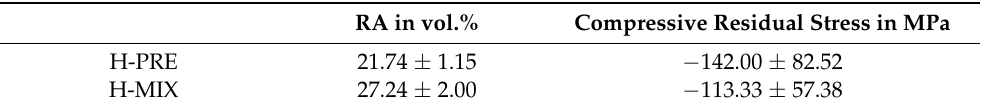
Table 6. Experimentally measured residual stresses inside bcc martensite and retained austenite content for H-PRE and H-MIX. RA in